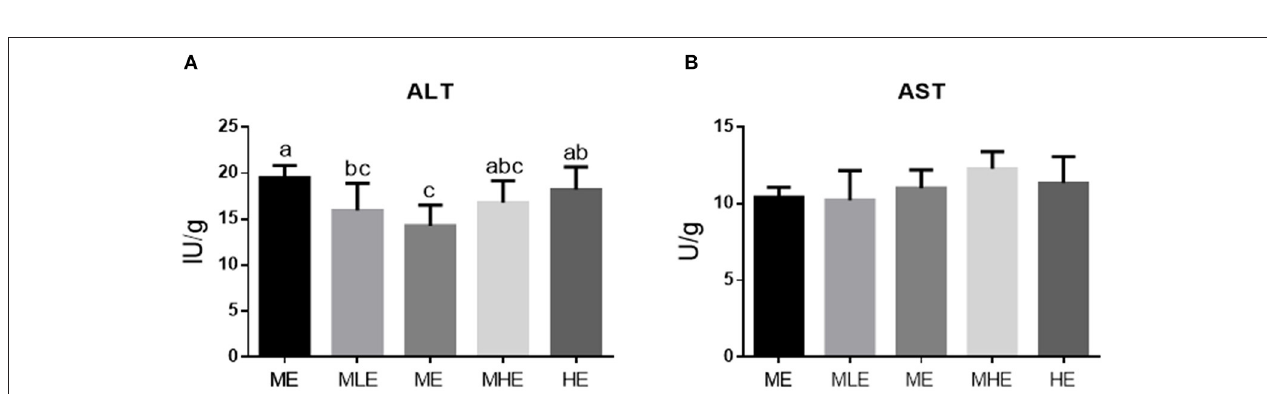
and the AOD values of LE and HE groups were significantly higher than those of the ME and MHE